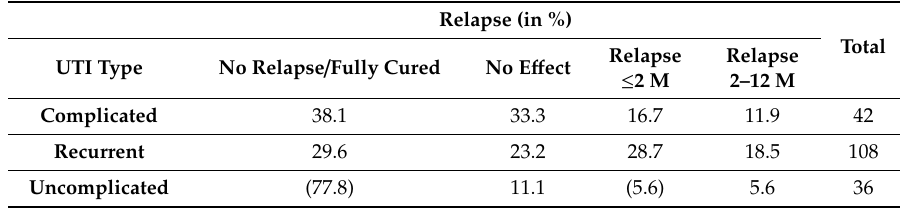
Table 4. Results of clinical e ffi cacy evaluation of fosfomycin treatment, case distribution according to UTI type, and clinical follow-up after fosfomycin administration. Statistically significant di ff erences (at p < 0.05) are shown in